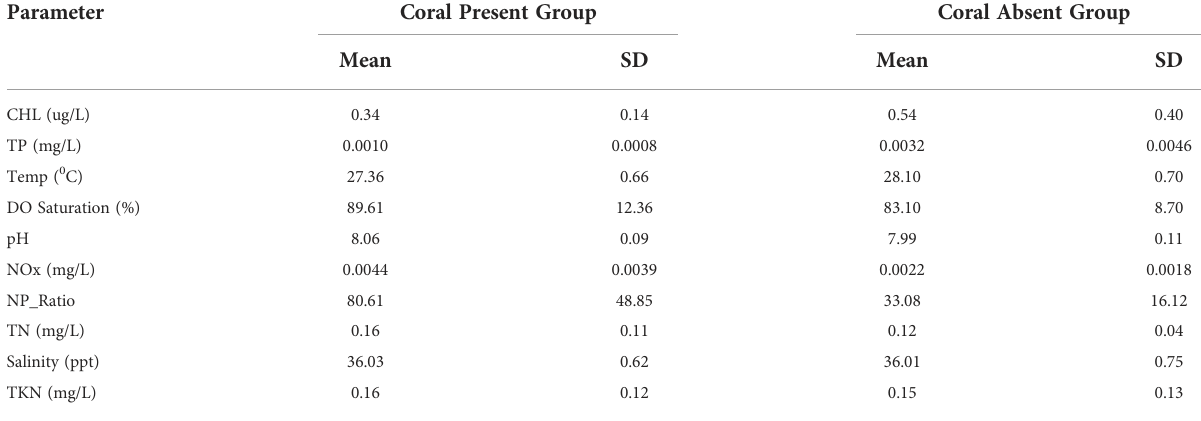
TABLE 1 Summary of means and Standard Deviations (SD) of each water quality and nutrient variable for coral present sites and coral absent sites. Parameter